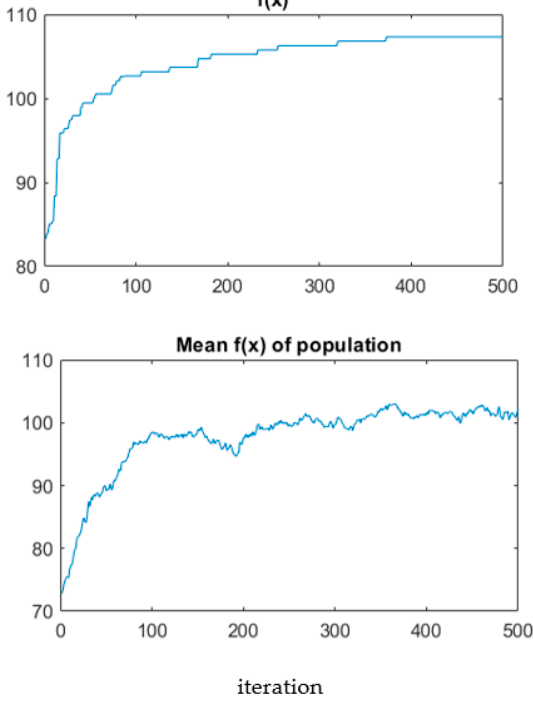
Figure 7. Performance of multi-adaptive genetic algorithm.